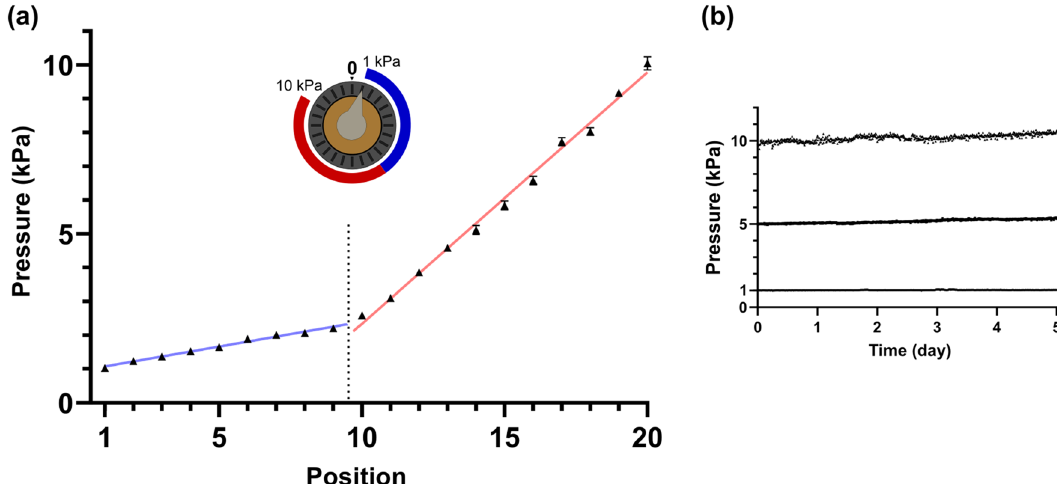
Figure 4. ( a ) Outlet pressure vs. control knob positions (15º steps). Pressures increased by 0.15-kPa increments between the 1st and 9th positions (blue), and 0.70-kPa increments between the 10 and 20th positions (red). ( b ) Outlet pressure stability test with pressures set to 1, 5, and 10 kPa, by turning the control knob to the 1st, 14th, and 20th positions, respectively, following the calibrated results in ( a ). The pressure was measured over 5 days to check the stability of the outlet pressure regulated by the device. The three outlet pressures were 1.1 ± 0.01 kPa, 5.2 ± 0.11 kPa, and 10.2 ± 0.20 kPa throughout the 5-day stability